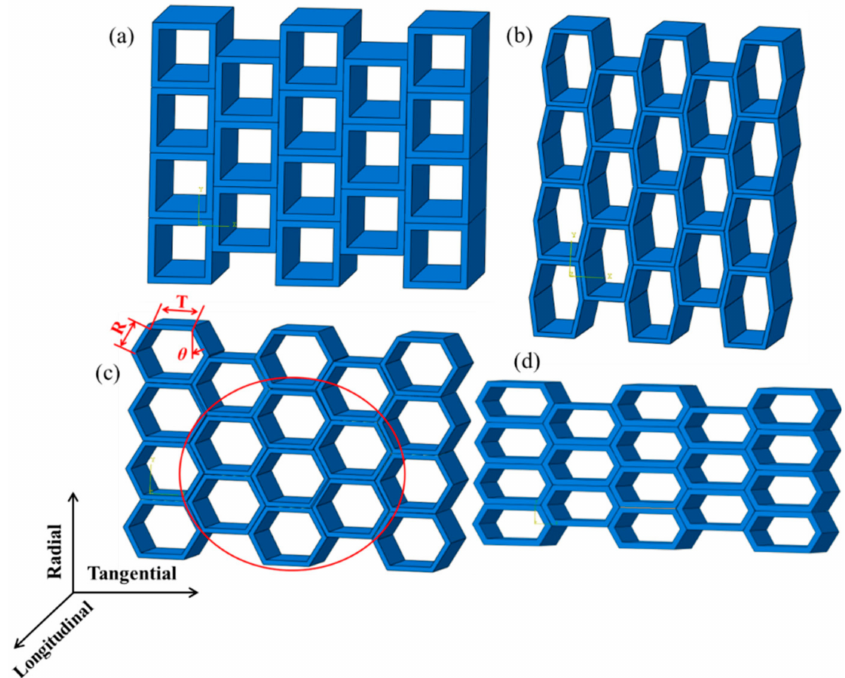
Figure 2. Schematic model of the wood cell. ( a ) θ = 0 ◦ and T / R = 1, ( b ) θ = 20 ◦ and T / R = 1, ( c ) T / R = 1.5 and θ = 30 ◦ , and ( d ) T / R = 3 and θ = 30 ◦